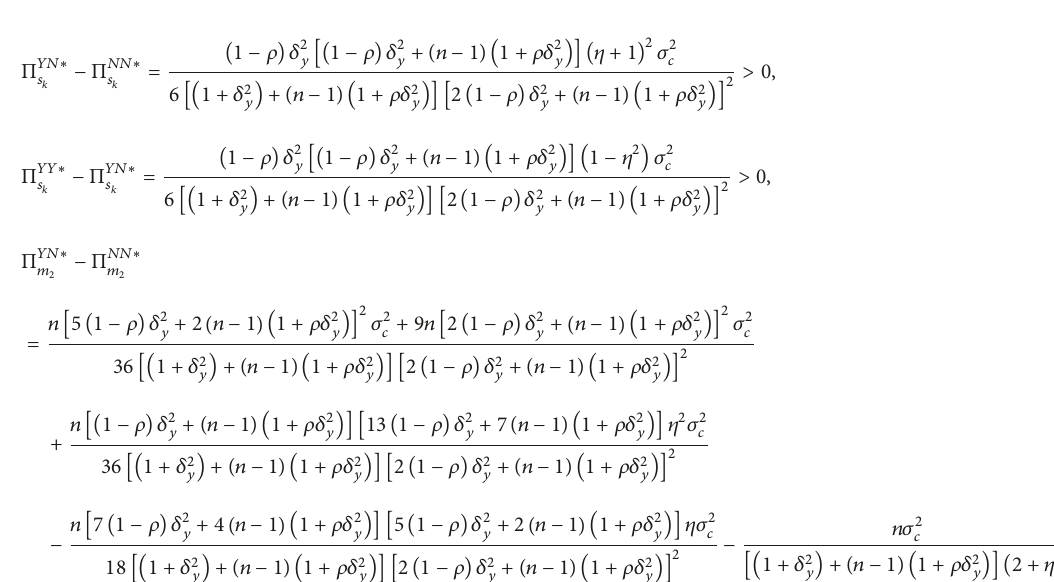
, 𝑉 𝑁 𝑚 , 𝑉 𝑁 𝑚 , 𝑉 𝑌 𝑠 , 𝑉 𝑌 𝑚 , and 𝑉 𝑌 𝑚 2 1 2 𝑘 𝑘